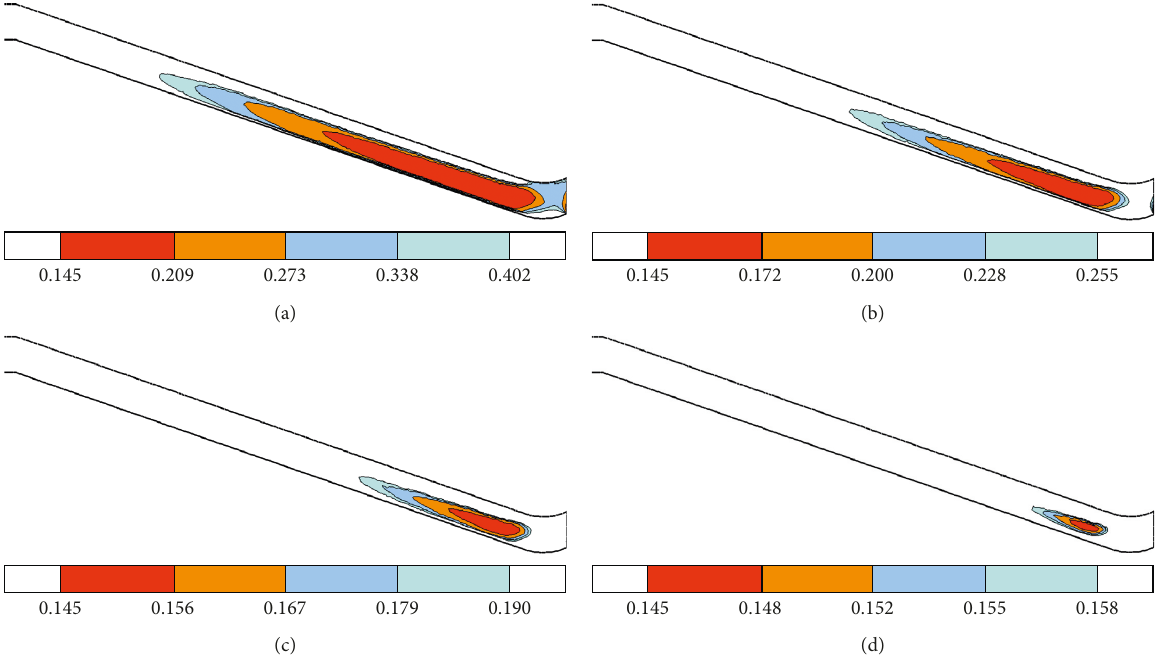
Figure 15: Prediction of potential cavitation zone in the central plane. (a)